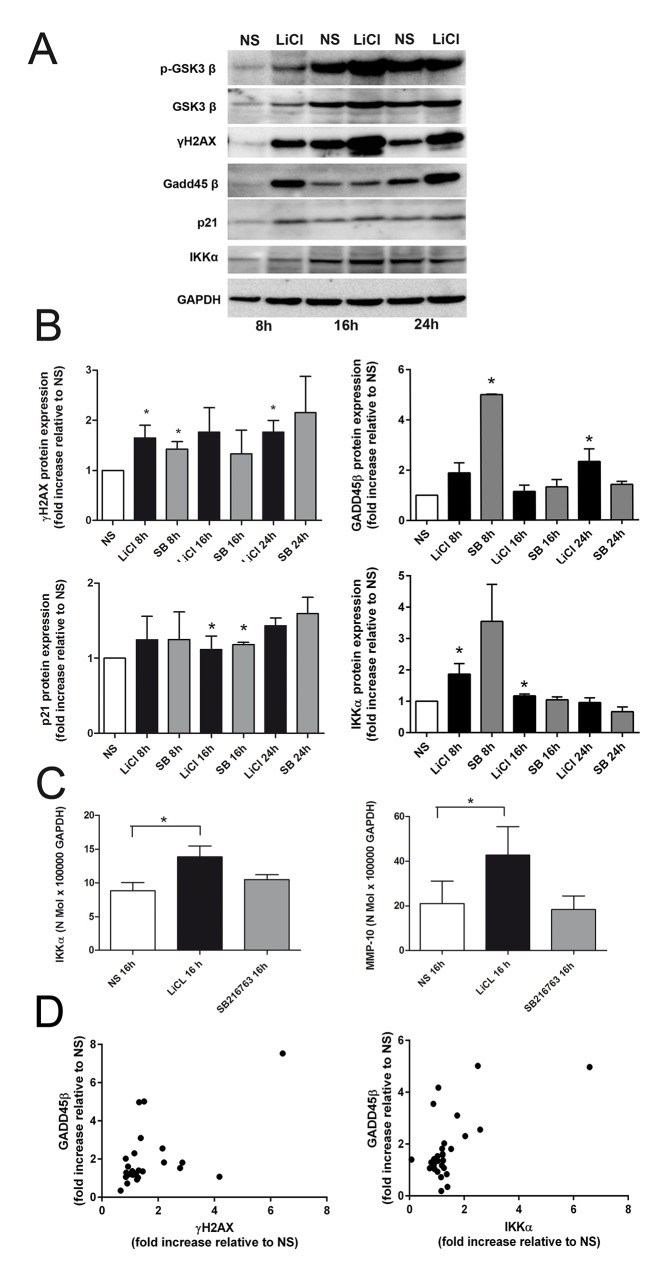
LiCl treatment determines a DNA damage response and increases expression of markers of chondrocyte differentiation.
4A, LiCl mediated increased GSK3β phosphorylation leads to a DNA damage response (DDR) (a representative example of one out of several experiments). The DDR includes markers of DNA damage (double strand breaks evidenced as γH2AX), increased expression of GADD45β and p21. 4B, Cumulative densitometric analysis following either 5mM LiCl (LiCl) or 10μM SB216763 (SB) treatment (“n” of experiments detailed within brackets for LiCl and SB216763) of the “fold change increase” in comparison of not stimulated samples (NS) of γH2AX (7 patients for LiCl and 5 for SB216763), GADD45β (6,2), p21 (7,3). IKKα (8,4) was also evaluated. 4C, 16 hours LiCl treatment significantly increased gene expression of IKKα (n = 3) and of its target gene MMP-10 (n = 3). 4D, Cumulative correlation analysis of the fold changes protein expression values, considering all the samples independently of time and stimulus, indicated the strong association between the hypertrophy marker GADD45β and both γH2AX (left graph: Spearman r value = 0.48, p = 0.0066, n = 25) and IKKα (right graph: Spearman r value = 0.37, p = 0.024, n = 30). *P < 0.05; **P < 0.01;***P < 0.001.